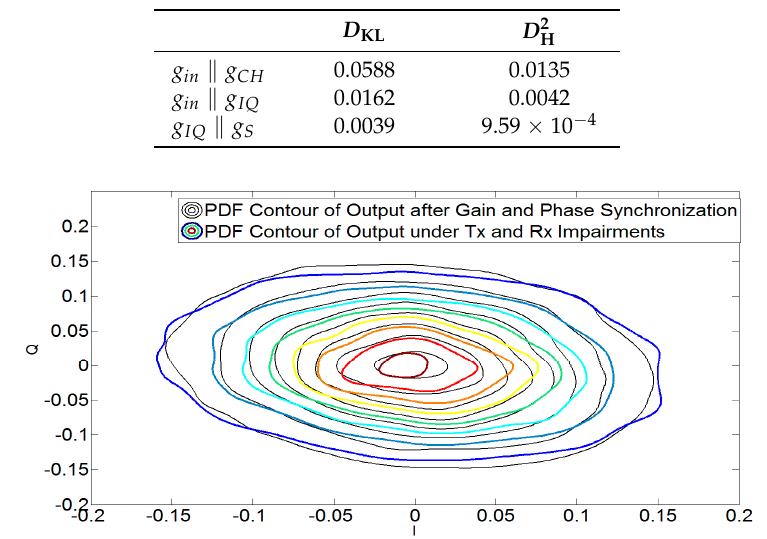
Table 3. Comparison of PDFs for g = g ’ = 0.5 dB and θ = θ ’ = − 2 degrees under 20 dB SNR and Multipath Channel for 16-QAM OFDM signal.